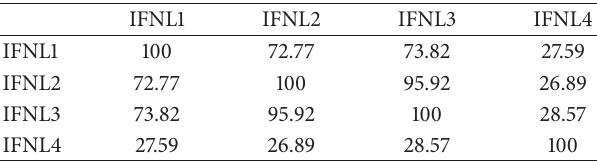
Table 1: Amio acid conservation of